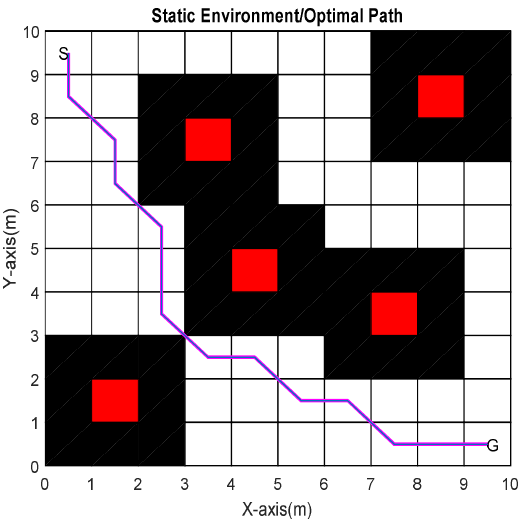
Fig. 10. Best Path found by Standard ACO for Experiment 1.